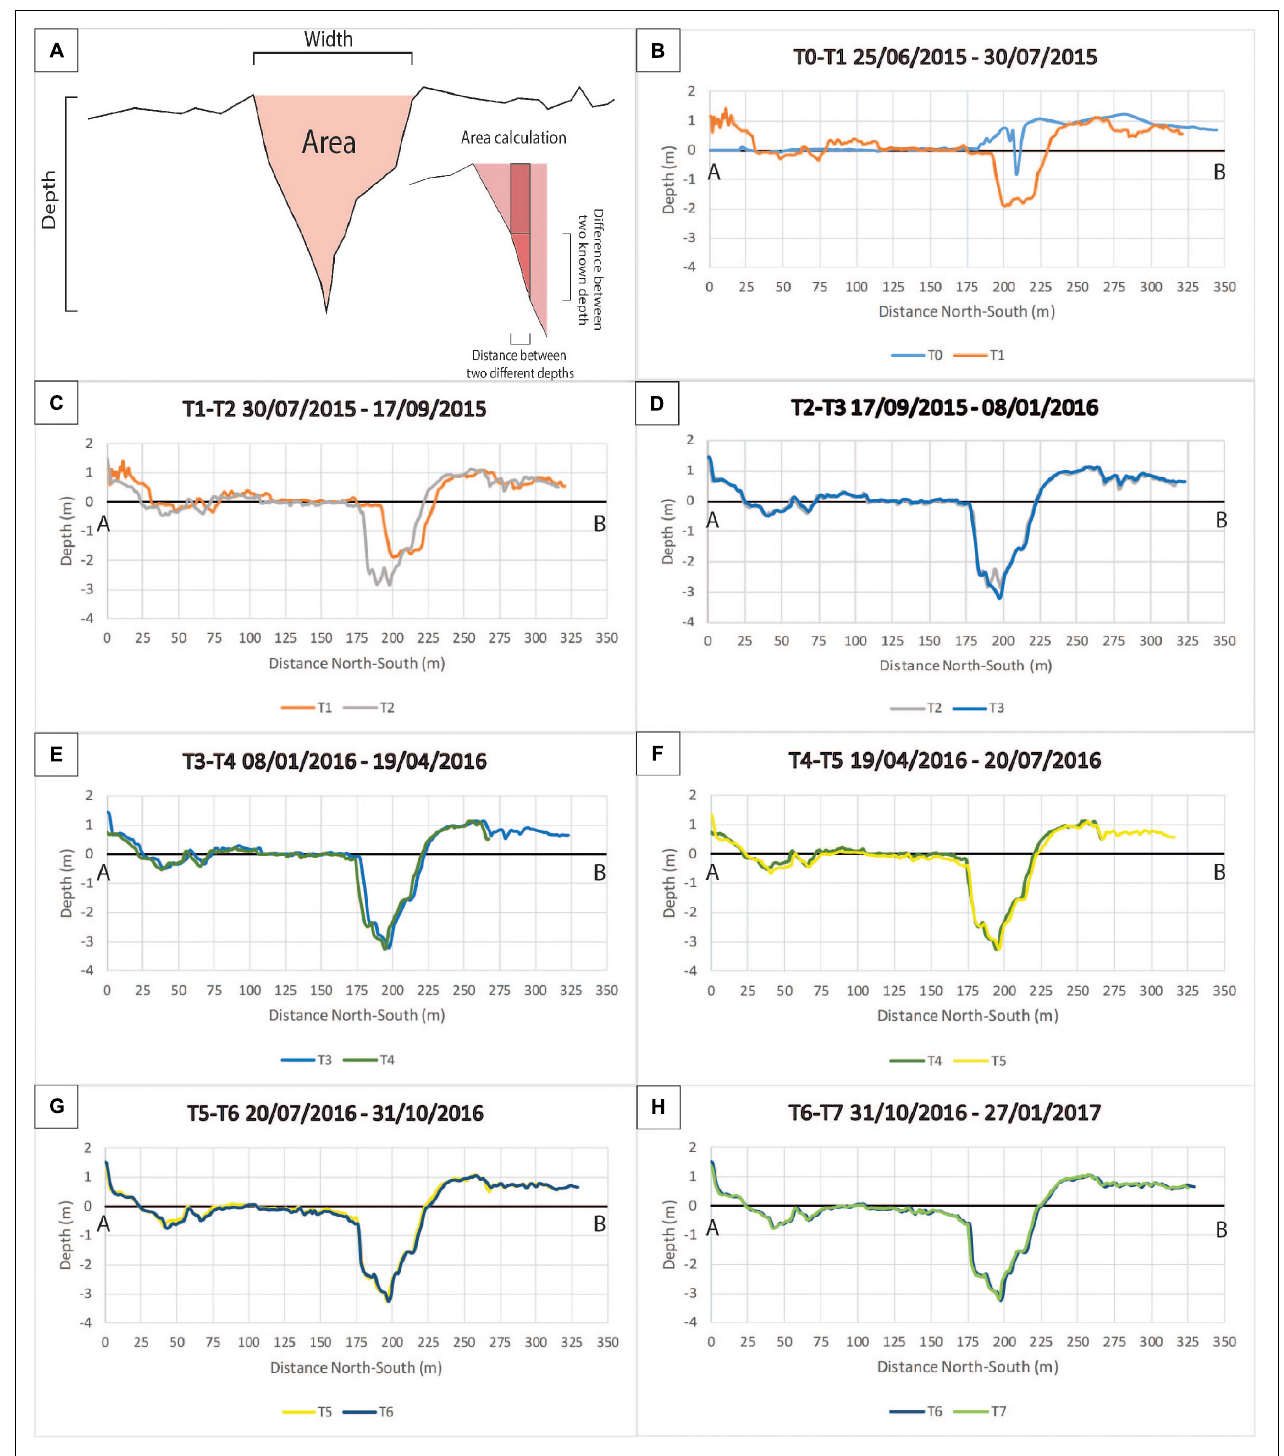
FIGURE 9 | (A) Scheme of the calculated parameters and (B–H) profile changes from the opening of the inlet in June 2015 to January 2017.